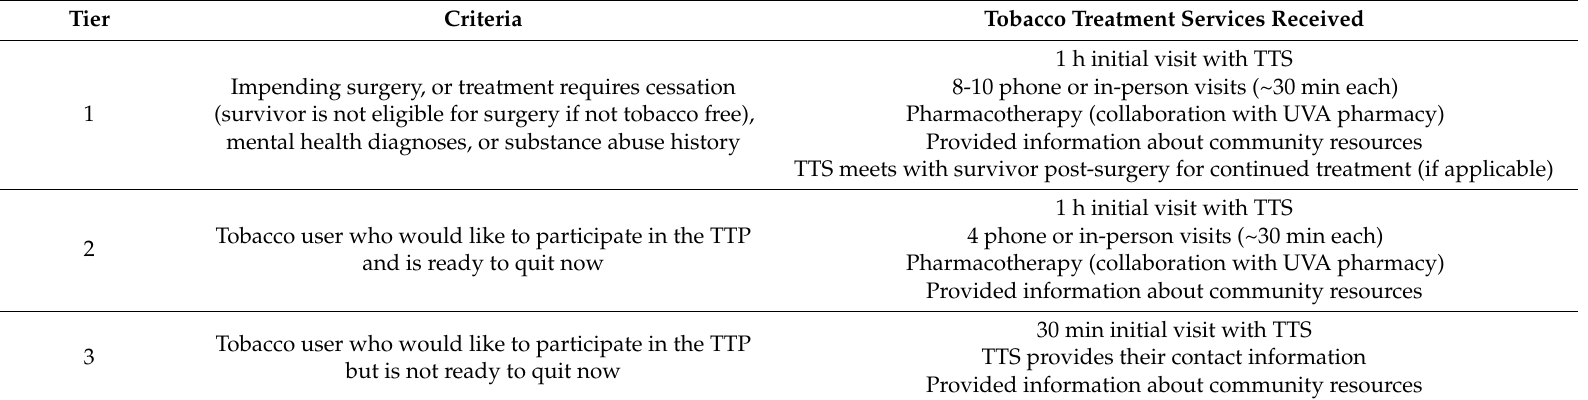
Table 2. UVA C3I Tobacco Treatment Program Tier